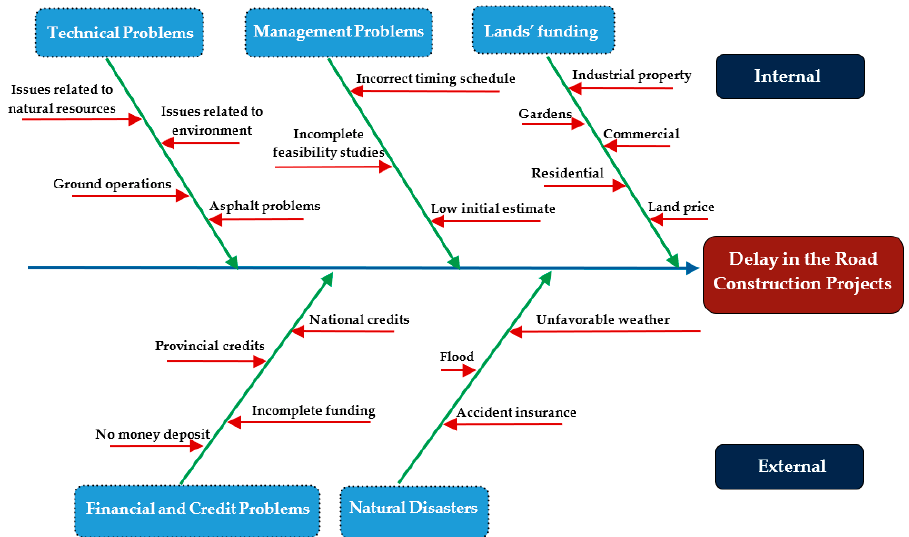
Figure 2. The qualitative prioritization of delay risks by the experts’ opinion.